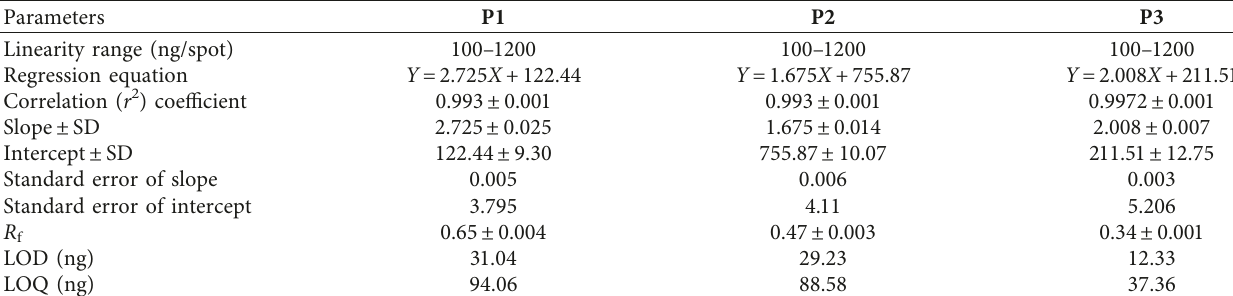
460nm (mobile phase: dichloromethane: methanol: formic acid (90: (cid:31) 0.34), P2 ( R f 0.47), and P1 ( R f 0.65). (b) 3D display of all tracks. (c) Chromatogram of (cid:31) (cid:31) (cid:31) 0.34; P2 , spot 7, R f 0.47; P1 , spot 8, R f 0.65). (d) Spectral comparison of all the tracks at 460nm. (cid:31) (cid:31) (cid:31) Table 5: R f and linear regression data for the calibration curve of P1 , P2 , and P3 ( n (cid:31) 6).